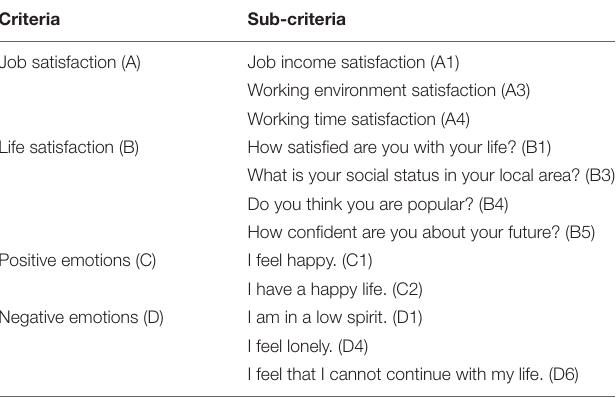
TABLE 5 | The employee well-being evaluation criteria system based on CFPS. Criteria Sub-criteria